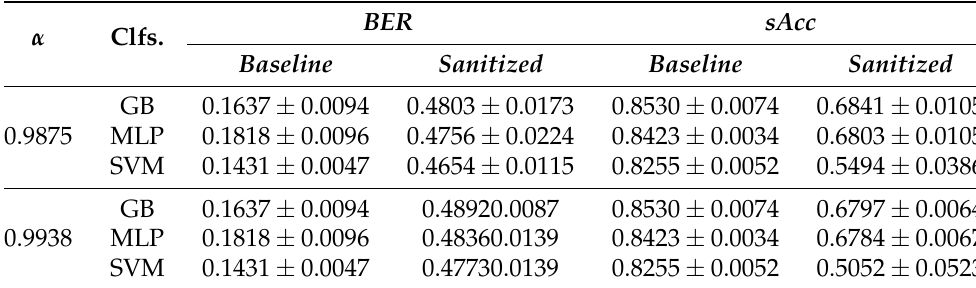
Table A2. Evaluation of GANSan ’s sensitive attribute protection on Adult.